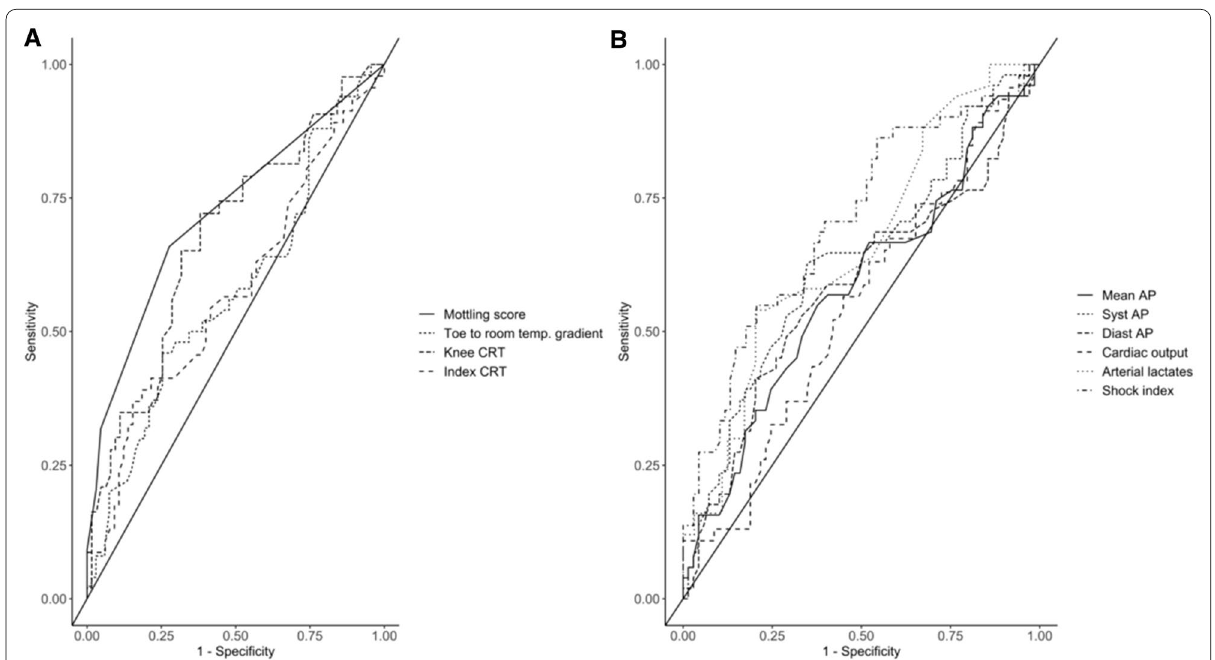
Fig. 2 Evaluation of the performance of different skin perfusion ( a ) and hemodynamics’ parameters ( b ) on the risk of post‑ETI